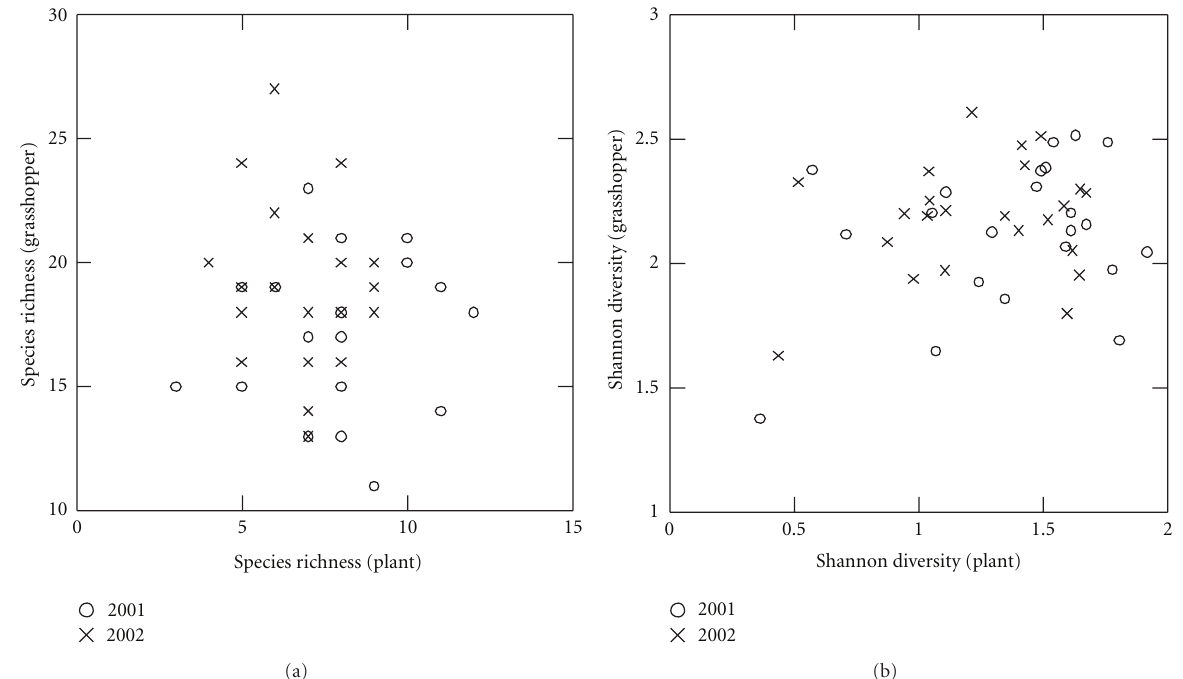
Figure 1: Relationship in 2001 and 2002 between (a) species richness of grasshoppers and plants and (b) Shannon diversity of grasshoppers and